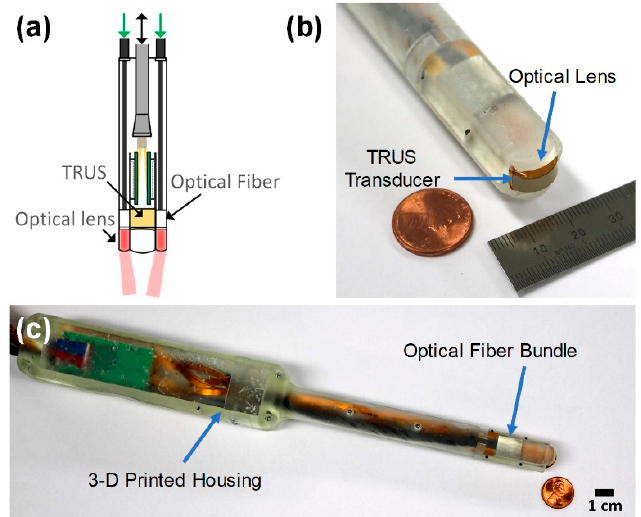
Figure 1. ( a ) Schematic of the developed transrectal ultrasound–photoacoustic (TRUS–PA) probe consisting of a TRUS array transducer, two optical fiber bundles, and two optical lenses. ( b , c ) Pho- tographs of the developed TRUS–PA probe.